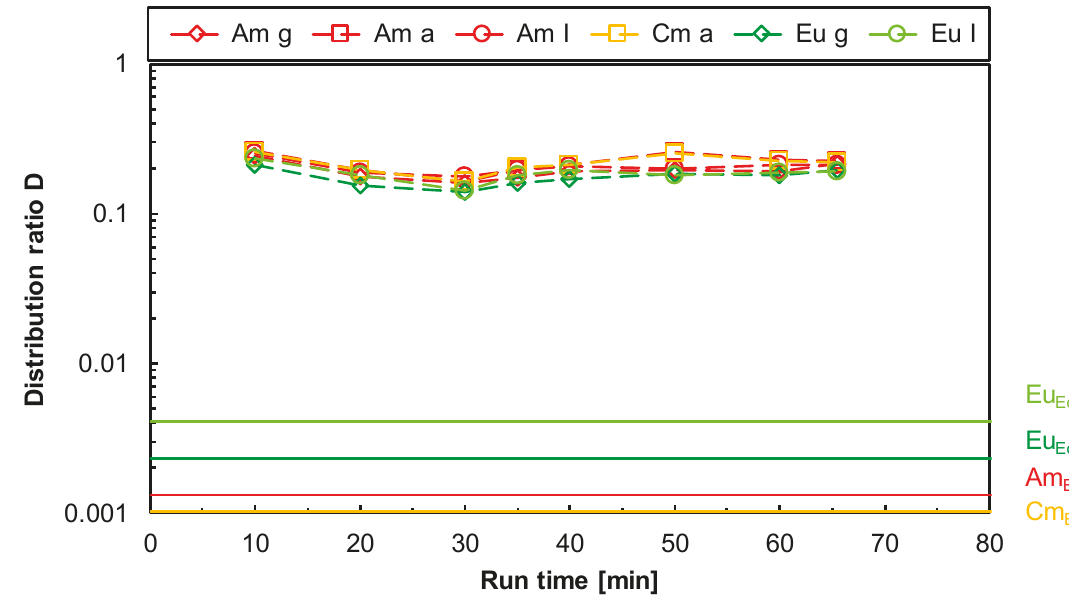
Figure 6. Am, Cm, and Eu distribution ratios as a function of the experimental run time (data points) and equilibrium values (horizontal lines) in the Ln stripping section single centrifugal contactor test. “g”, “a”, and “I” indicate values measured by gamma and alpha spectrometry as well as ICP-MS,